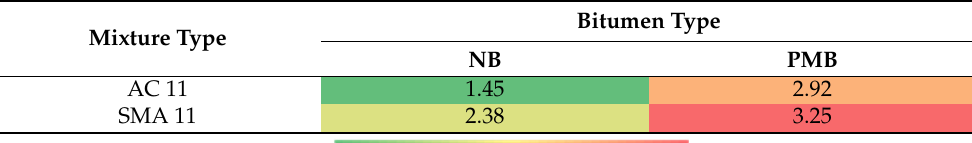
Table 6. Comparison of fits for different asphalt mixtures.